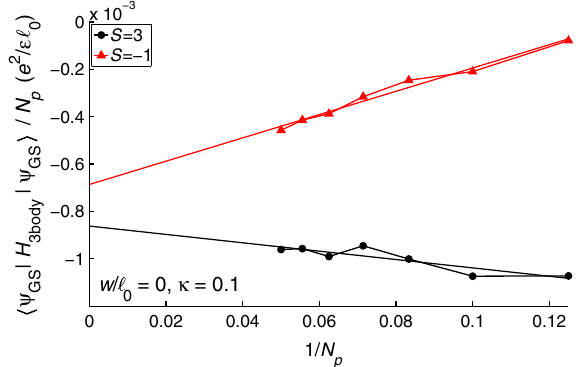
FIG. 2. The expectation value of the three-body terms in the j H j Ψ i per particle at various system Hamiltonian h Ψ 3 body GS GS j H j Ψ i is the leading contribution to the energy sizes. h Ψ 3 body GS GS difference between these states computed perturbatively in κ . N S ¼ 3 and number of holes for p is the number of electrons for S ¼ − 1 . The energy difference between the extrapolated values ð 3 Þ j is 0 . 00018 e 2 = ϵ l 0 ¼ 0 . 12 κ j V 3